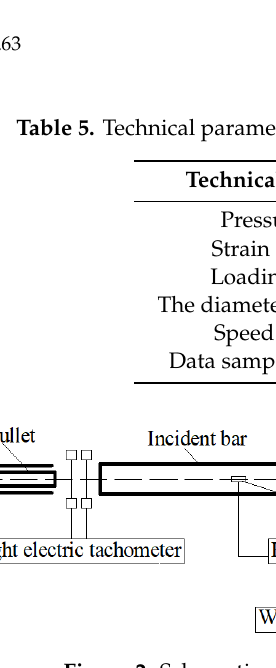
Figure 2. Schematics of the 74 mm-diameter SHPB test device.